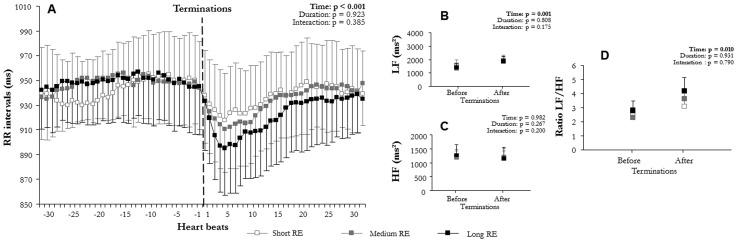
Comparison of autonomic modulation at terminations according to apnea duration: (A) RR intervals (RR), (B) low (LFWV) and (C) high frequency (HFWV) wavelet power, and (D) LFWV/HFWV ratio before and after apnea terminations according to apnea duration: short (10 s≤apneas<20 s), medium (20 s≤apneas<30 s), and long (apneas≥30 s) (mean ± SEM).An overall effect on RR intervals, LFWV, and LFWV/HFWV ratio appeared between before and after apneas terminations. Apneas induced a sympathetic-dependent RR decrease, which was not modulated by apnea duration.